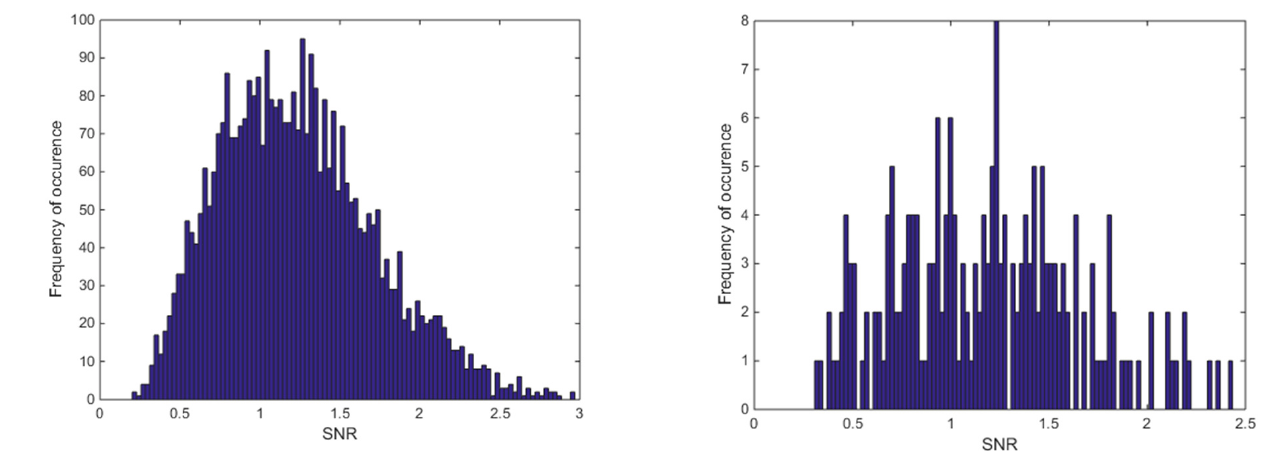
Figure 12. Histogram of signal-to-background ratios for the low-mixing-rate dataset. Table 7. Average RMSE results when foreground spectra are used for mixing ‐ rate estimation in the “low ‐ mixing ‐ rate mixture” dataset (Mixing ‐ rate range used for synthesizing mixtures is: [10 − 3 10 − 1 ], Min: 10 − 3 , Max: 10 − 1 ). Bold numbers indicate best performing algorithm.